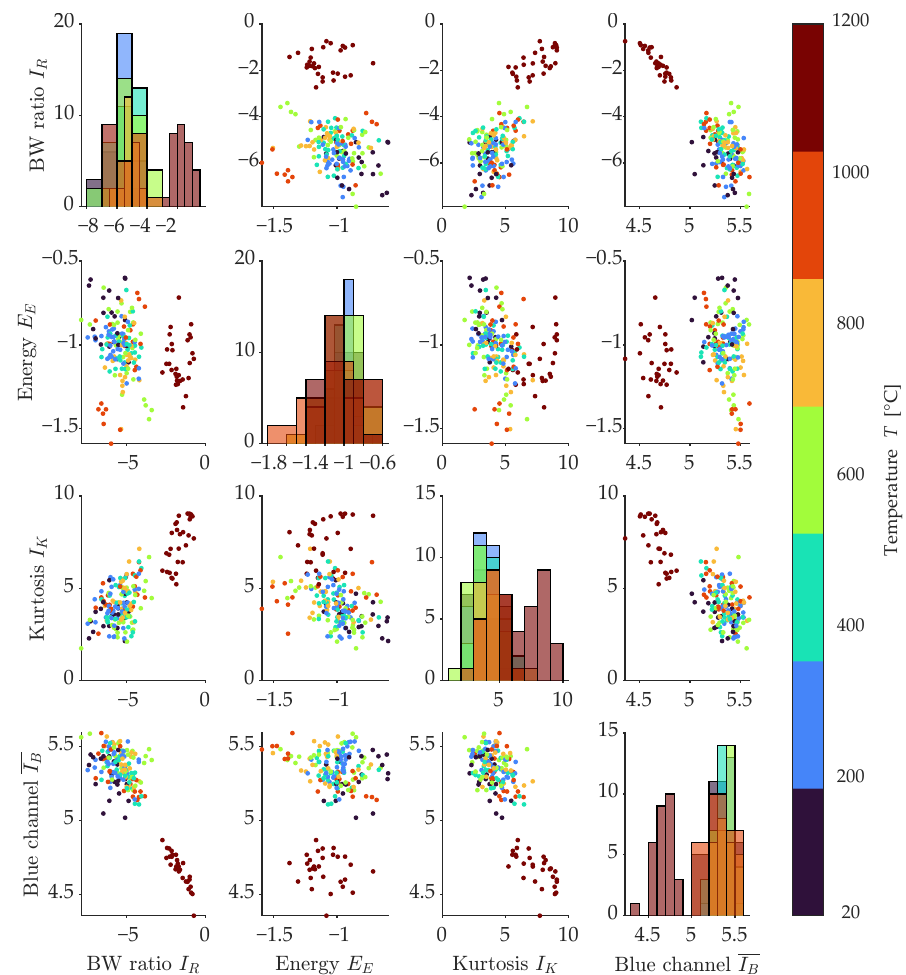
− 1.5 Figure 15. Correlation diagram of selected variables: R BW , E I , K I , ∑ G channel